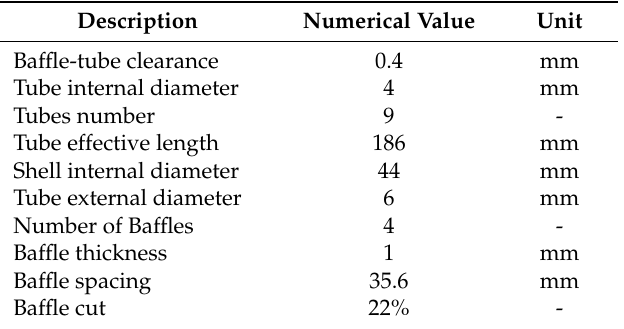
Table 1. Structural parameters of the STHXs.